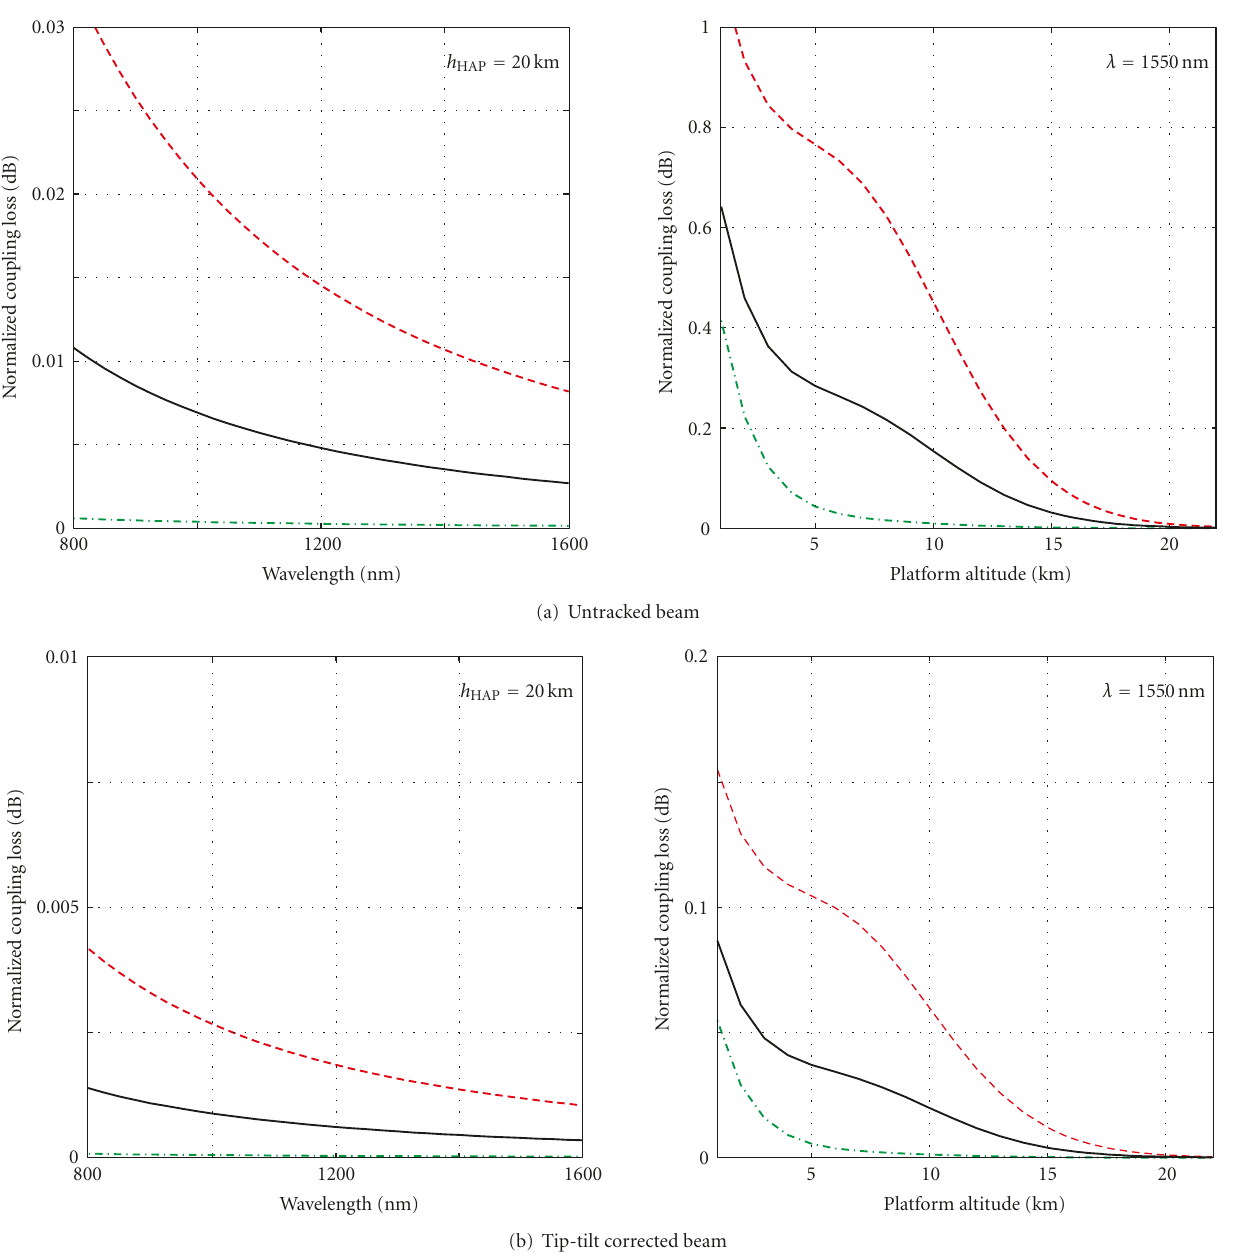
Figure 7: Normalized coupling loss into a standard single-mode fiber for a GEO-to-HAP downlink versus wavelength λ , and platform altitude h HAP in the case of (a) an untracked beam and (b) a tip-tilt corrected beam. (dashed-dotted line: ν wind = 0m / s, C 2 (0) = 1 . 7 · 10 − 14 m − 2 / 3 , dashed line: ν wind = 20m / s, C 2 solid line: ν wind = 3m / s, C 2 n